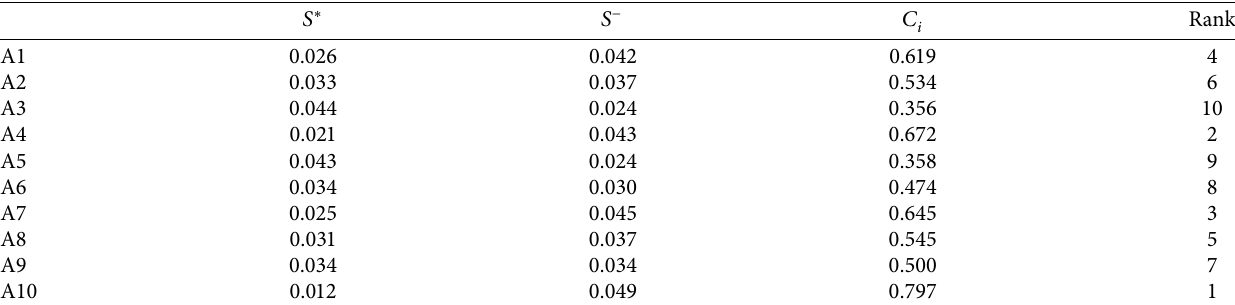
) , and ranking of alternatives with i